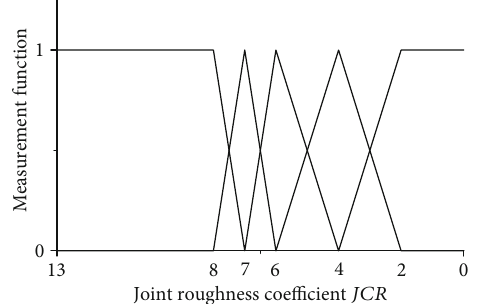
Figure 8: Uncertainty measurement function of joint roughness coe ffi cient.